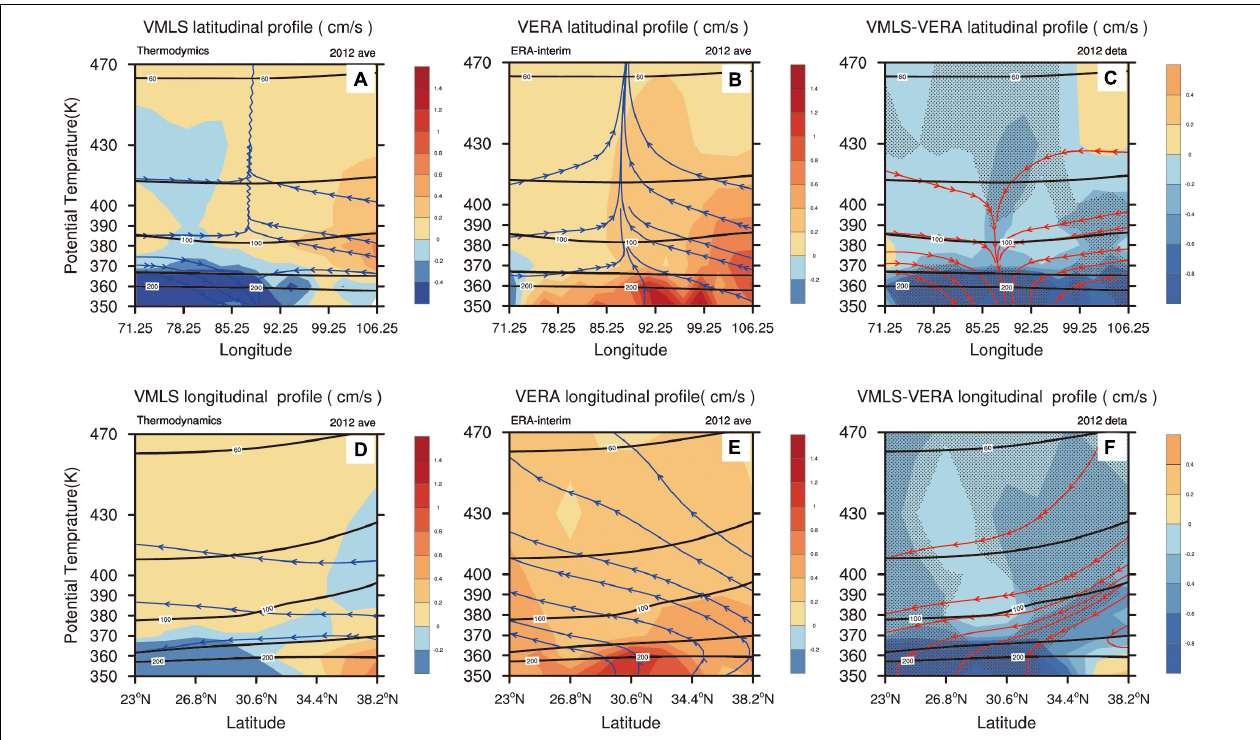
FIGURE 7 | Daily mean V MLS (A,D) , V ERA − I (B,E) and the deviation between them (C,F) in JJAS 2012. Panels (A–C) are the latitudinal profiles along 80.5 ◦ E and (D–F) are the longitudinal profiles along 32.5 ◦ N. The shading represents the vertical velocity field, the streamlines are the vertical and horizontal wind fields and the contour lines are the air layer. The dotted regions in panels (C,F) represent the area that passed the 95% significance